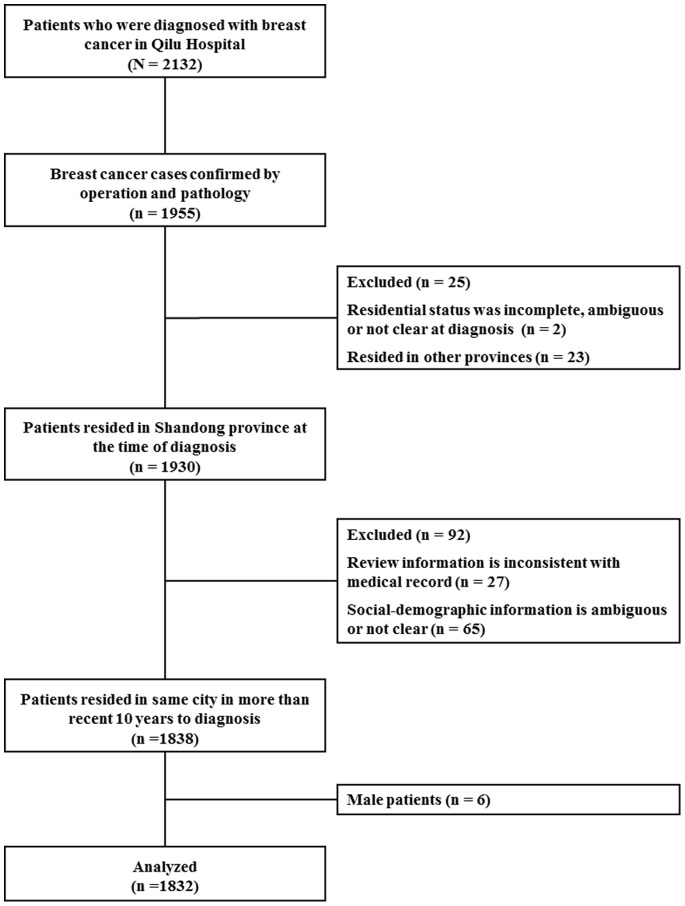
Study sample flow diagram.